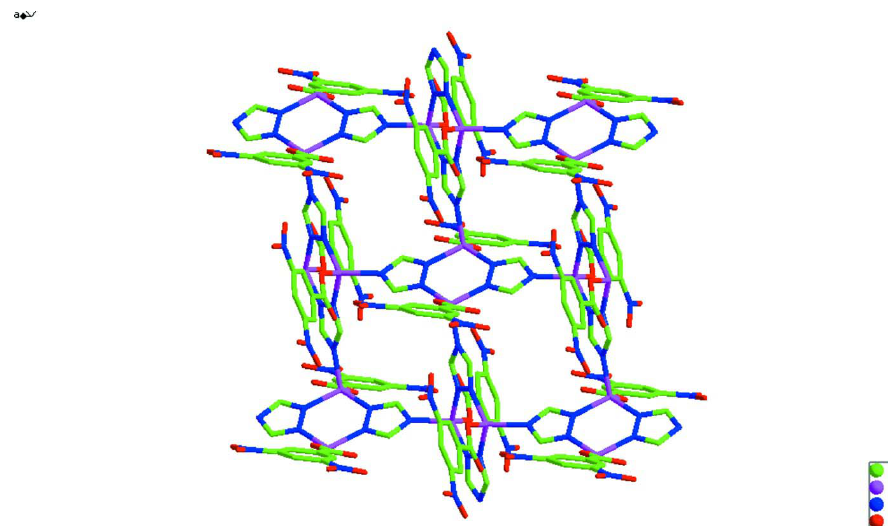
View of the two-dimensional net. Poly[(3,5-dinitrobenzoato)- µ